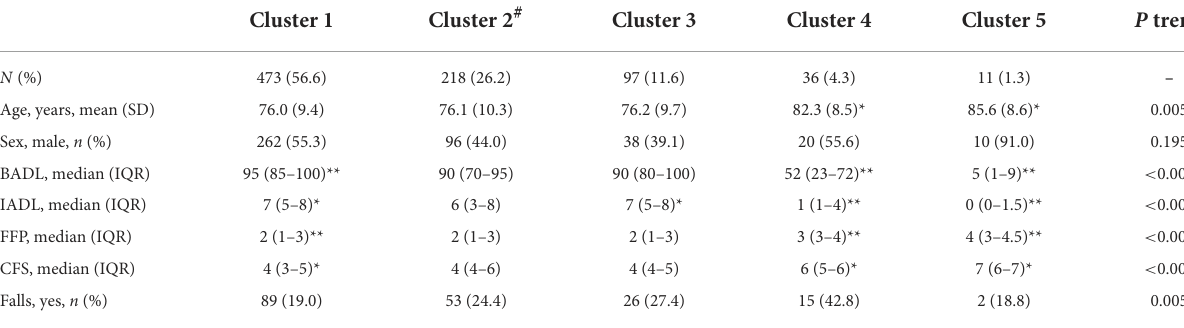
TABLE 3 Association of clusters with frailty, age, sex ADL, IADL, and falls.